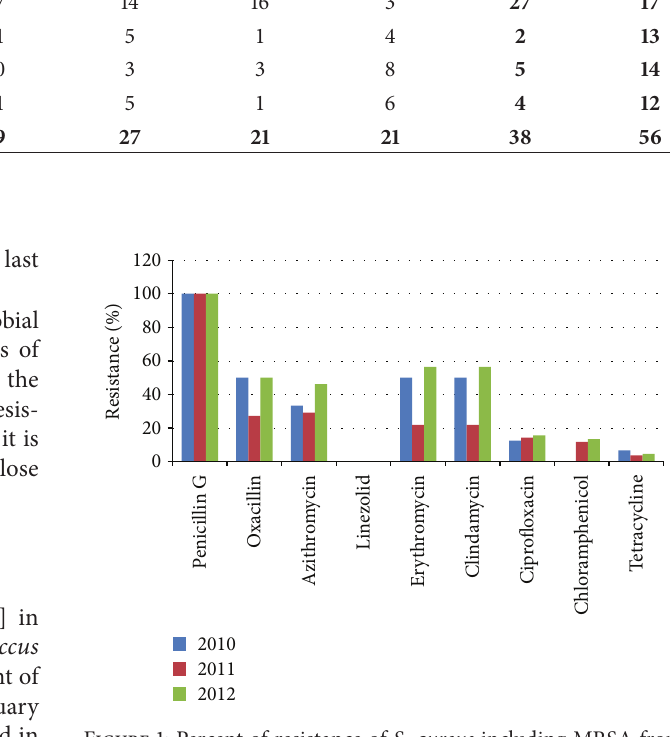
Figure 1: Percent of resistance of S. aureus including MRSA from 2010 to